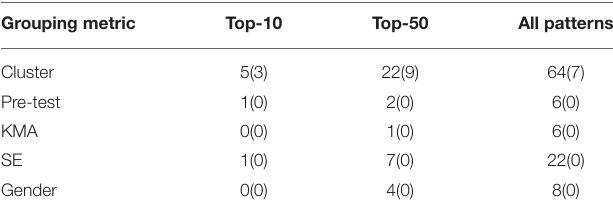
TABLE 4 | Summary of differential sequential mining results based on each grouping metric. Grouping